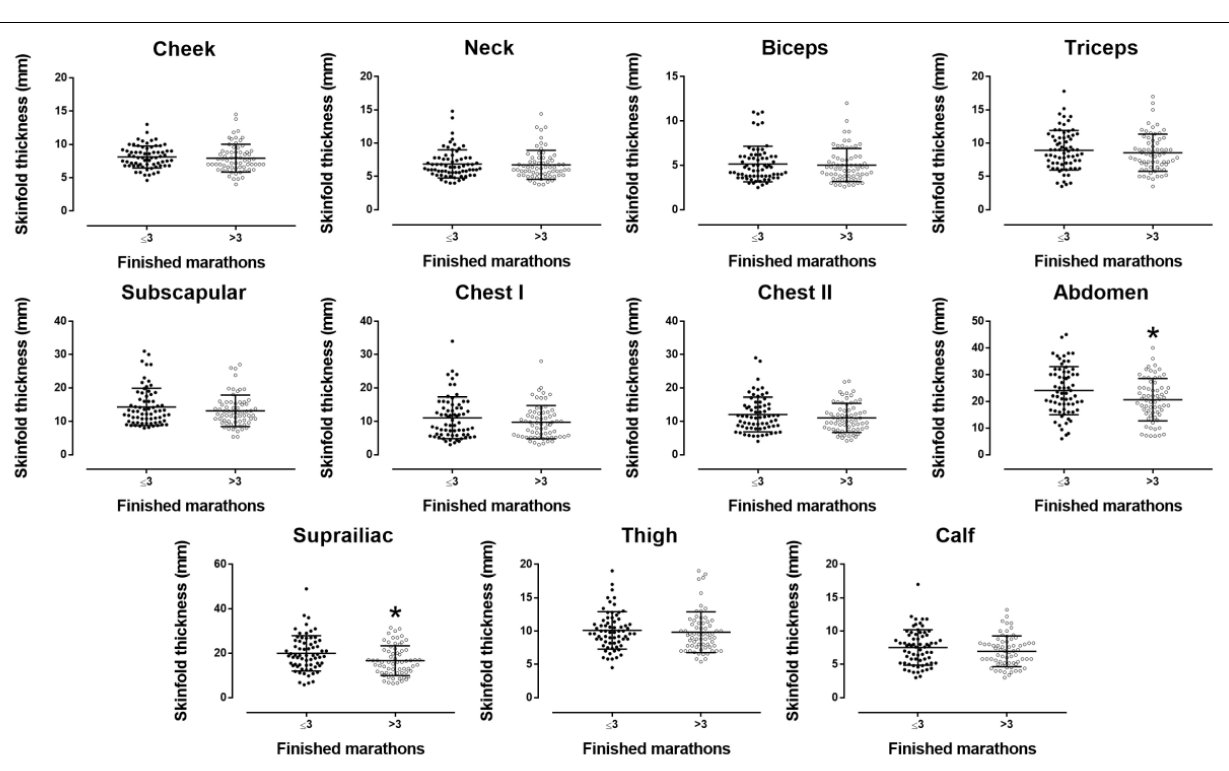
FIGURE 2 | Skinfold thickness of 11 anatomical sites by number of marathon finishes. Error bars represented standard deviations. * p <